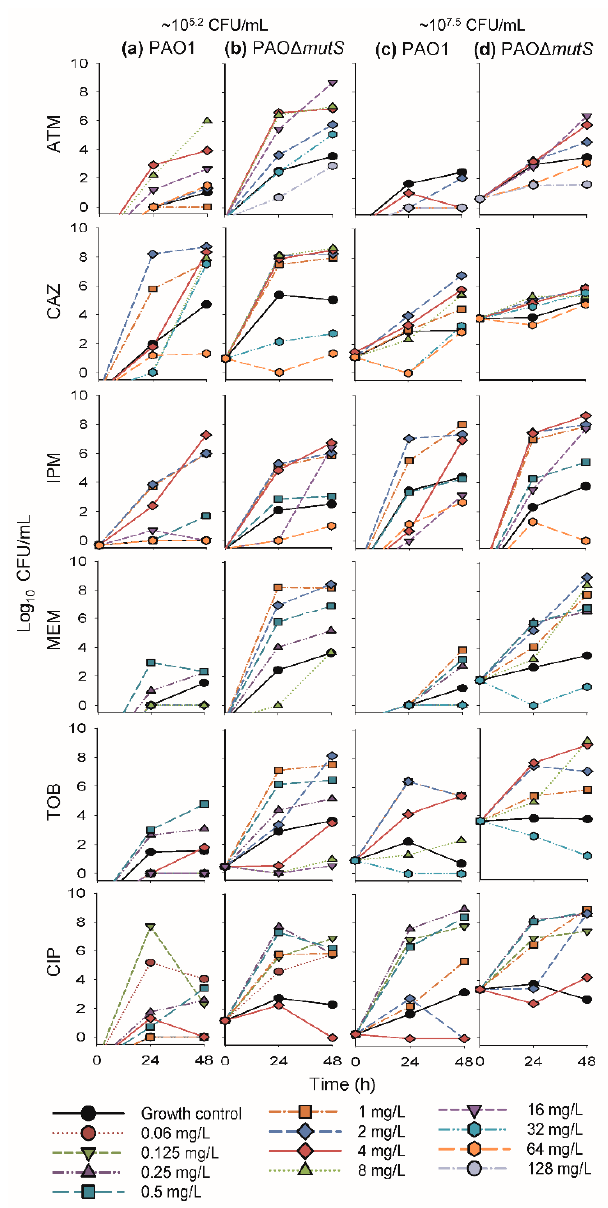
Figure 3. The log 10 viability counts (CFU / mL) of bacterial growth on antibiotic-containing agar plates (resistant populations) versus time for non-hypermutable PAO1 and hypermutable PAO ∆ mutS in 48-h static concentration time-kill experiments at two initial inocula (lower ~10 5.2 CFU / mL on the left, ( a ) PAO1, ( b ) PAO ∆ mutS , and higher ~10 7.5 CFU / mL, on the right, ( c ) PAO1, ( d ) PAO ∆ mutS ). Antibiotic concentrations in agar were: 20 mg / L aztreonam (ATM), 10 mg / L ceftazidime (CAZ), 10 mg / L imipenem (IPM), 5 mg / L meropenem (MEM), 2.5 mg / L tobramycin (TOB), and 1.25 mg / L ciprofloxacin (CIP). The following concentrations were studied against both inocula of each strain (unless denoted otherwise): aztreonam 1 a , 2, 4, 8 b , 16, 32 c , 64 a,d , and 128 c,d mg / L; ceftazidime 1, 2, 4, 8, 32, and 64 mg / L; imipenem 0.5, 1, 2, 4, 16, and 64 mg / L; meropenem 0.25, 0.5, 1, 2, 8, and 32 d mg / L; tobramycin 0.25 b , 0.5 b , 1, 2, 4, 8, 16 b , and 32 d mg / L; and ciprofloxacin 0.0625 b , 0.125, 0.25, 0.5, 1, 2 d , and 4 mg / L. a Concentration was only used against the lower inoculum (10 5.2 CFU / mL) of PAO1. b Concentration was only used against the lower inoculum (10 5.2 CFU / mL) of both strains. c Concentration was only used against the lower inoculum (10 5.2 CFU / mL) of PAO ∆ mutS . d Concentration was only used against the higher inoculum (10 7.5 CFU / mL) of both